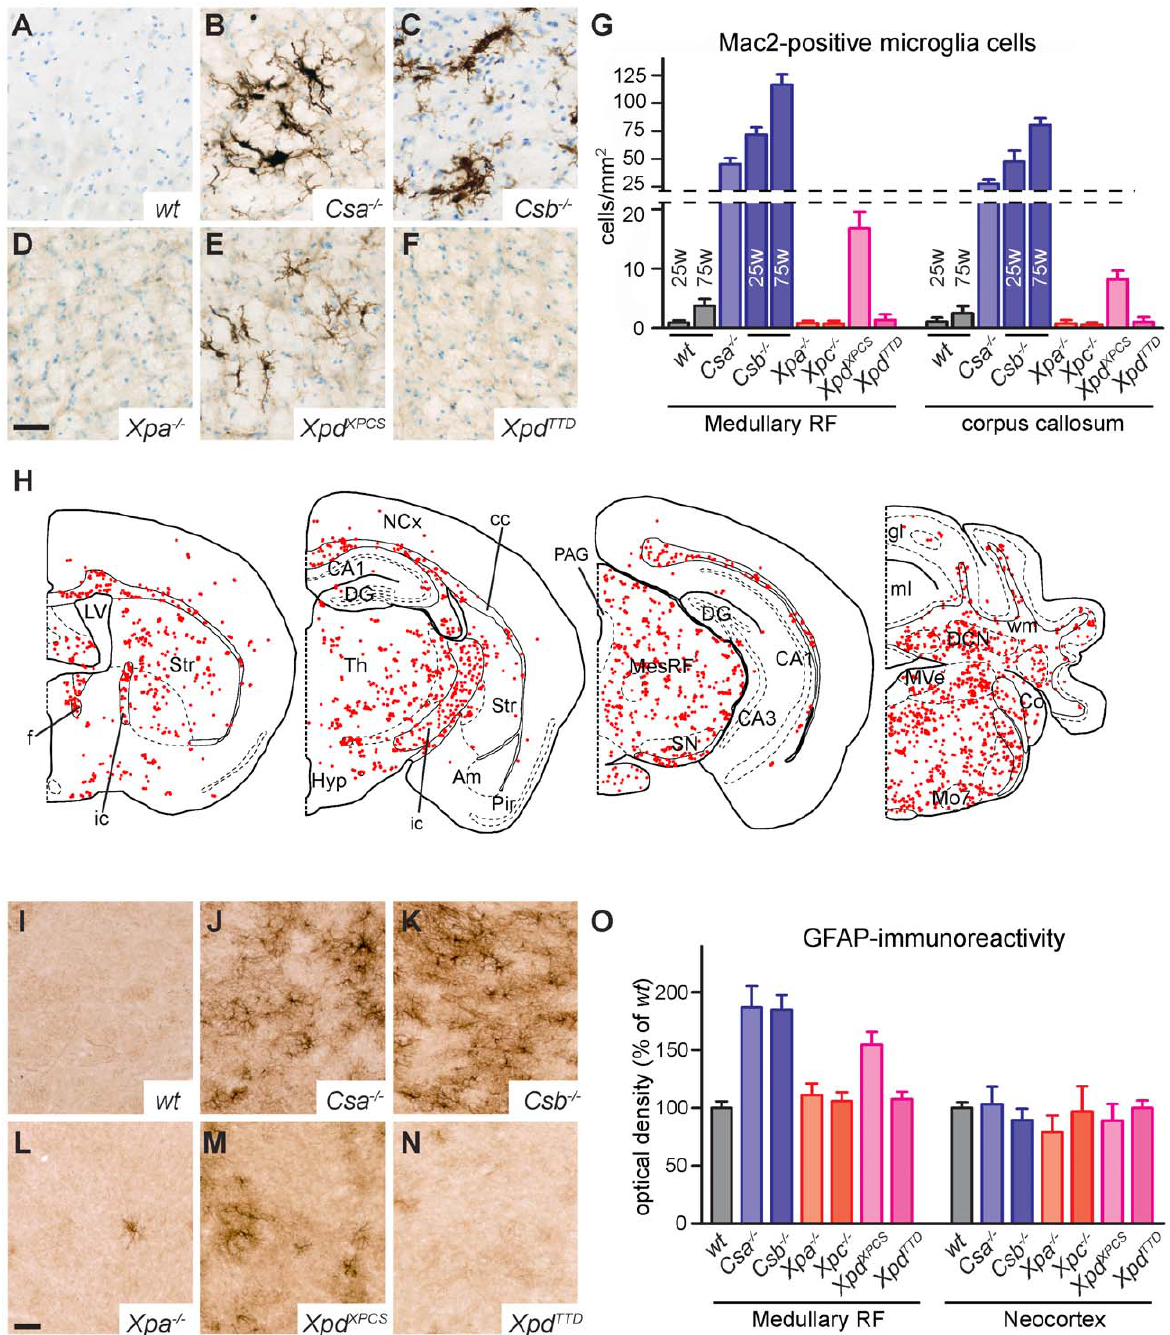
Figure 2. TCR–deficient mice show microglia and astrocyte activation in the white matter. A–F) Mac2-immunostaining of activated microglia in the medullary reticular formation of 25 week old wild-type and NER-deficient mice showing the presence of Mac2-positive microglia cells in the reticular formation of Csa 2 / 2 (B), Csb 2 / 2 (C) and Xpd XPCS (E) mice. G) Bar graph showing the density of Mac2-labeled cells in the medullary reticular formation and corpus callosum of NER-mutant mice. Values are means 6 SE of 3 or 4 mice, while values per mouse are based on analysis of 4 sections. H) Plot of Mac2-positive cells in selected transverse brain sections of 25 week old Csb 2 / 2 mouse illustrating the widespread distribution of activated microglial cells in regions containing myelinated axons such as the corpus callosum (cc), the internal capsule (ic), the fornix (f), the cerebellar white matter (wm), the mesencephalic (MesRF) and medullary reticular formation. No or a low number of Mac2- immunoreactive cells occur in grey matter regions, such as the Neocortex (NCx), the hippocampal subfields (DG [dentate gyrus], CA1 and CA3), amygdala (Am), piriform cortex (Pir), the cerebellar cortical granular (gl) and molecular layers (ml), and the medial (MVe) and lateral vestibular (LVe) nuclei. I–O) Photomicrographs and optical density measurements (O) of GFAP-immunoperoxidase staining in the medullary reticular formation of NER-deficient mice showing increased staining in Csa 2 / 2 , Csb 2 / 2 and Xpd XPCS mice as compared to the other genotypes. Optical densities were determined from TIFF files using MetaMorph 4.6 image analysis software. Values are means 6 SE of 3 mice, while values per mouse are from 3 sections. To minimize variability resulting from the staining procedure all sections used for the graph were stained in a single session using the same reagents. Scale bars: 50 m m (D, L).